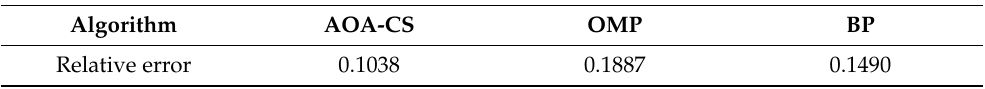
Table 1. Comparison of Reconstruction Performance of Different Algorithms with Fixed Compres- sion